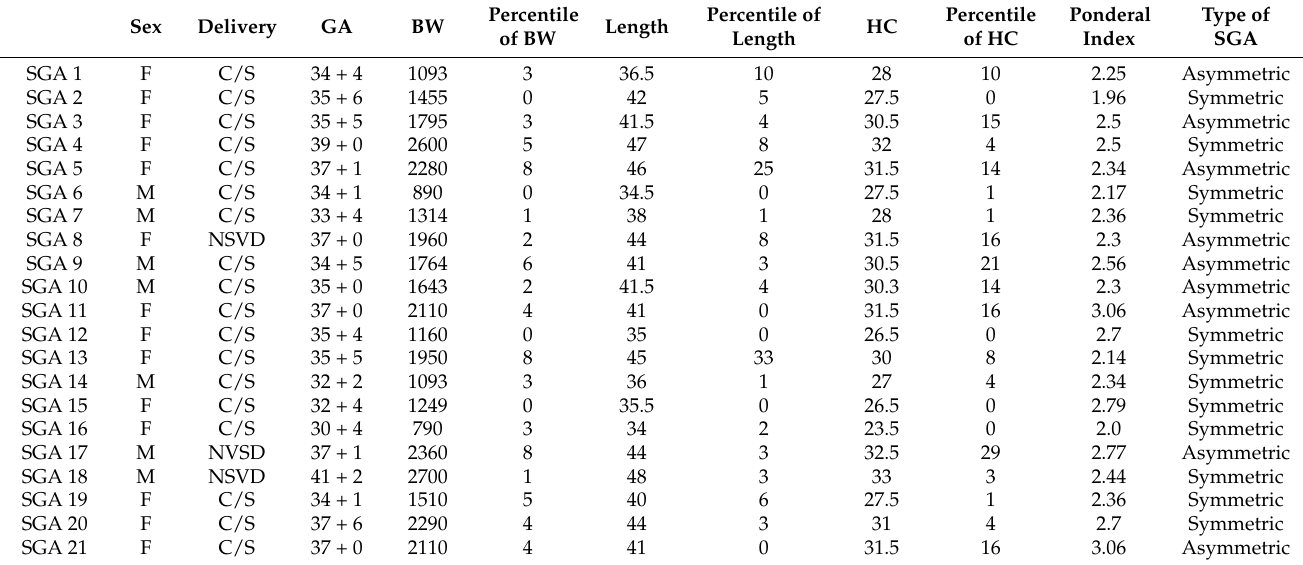
Table 1. Clinical characteristics of patients.